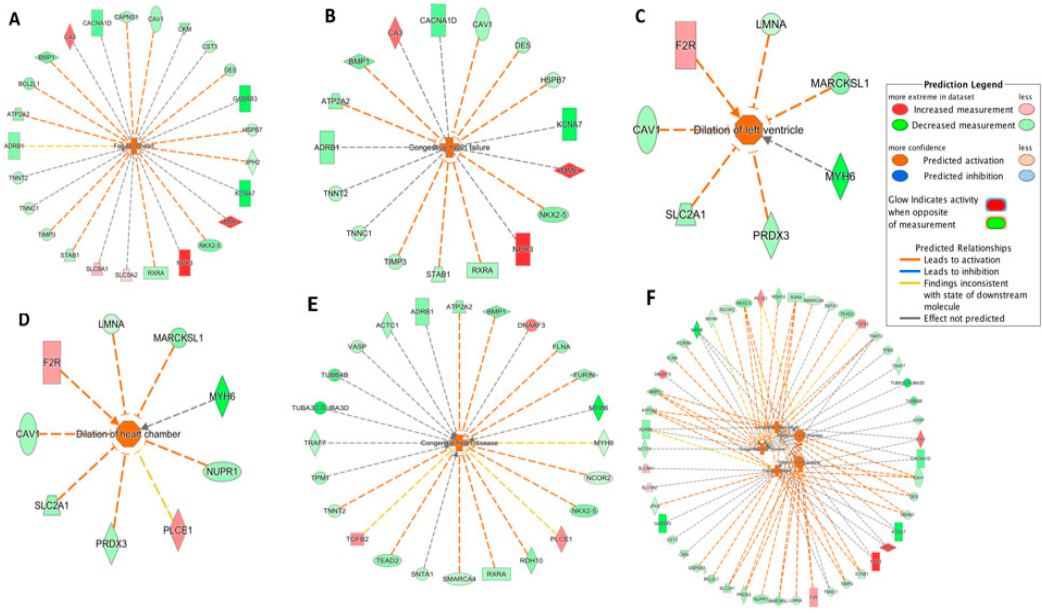
Figure 3. Toxicity pathways significantly activated in DCM through IPA-Tox: ( A ) failure of heart; ( B ) congestive heart failure; ( C ) dilation of left ventricle; ( D ) dilation of heart chamber; ( E ) congestive heart disease; ( F ) integrated toxicity pathways. As an example, in Figure 3A, the DES gene was downregulated as indicated by the green color and the downregulation of DES further promoted (indicated by the orange dash line) the activation of failure of heart, as indicated by the orange color. Other indicators are explained in the Prediction Legend section. Table 4. DEGs common among three or more toxicity pathways through IPA-Tox analysis.